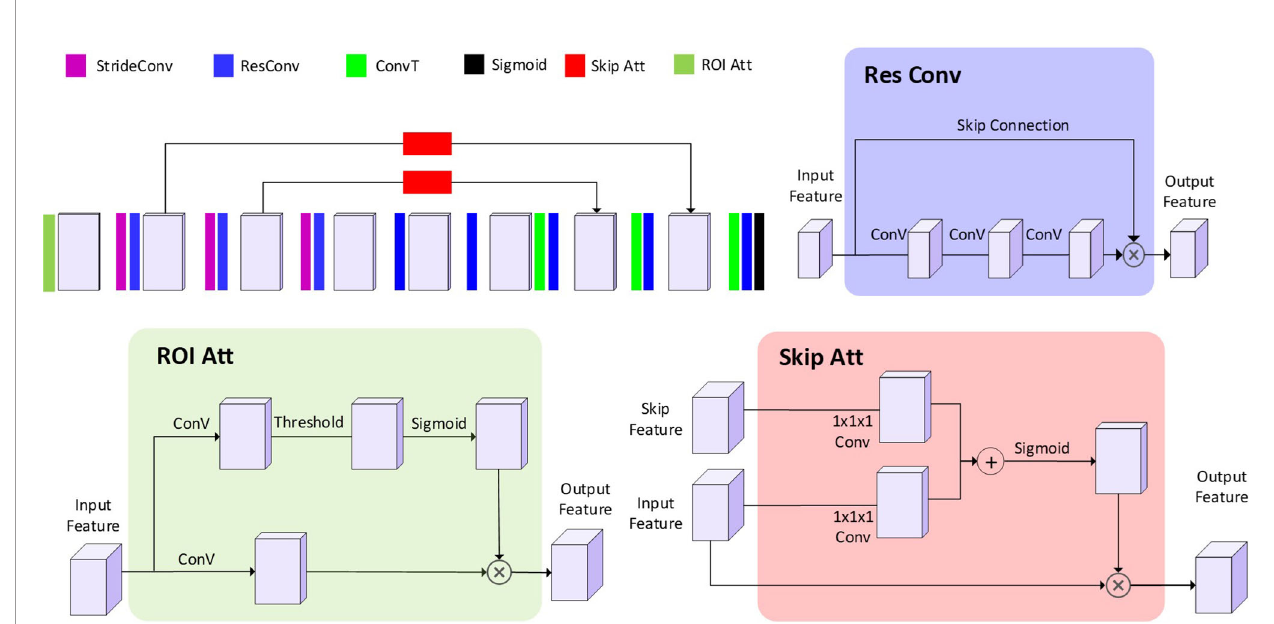
FIGURE 2 | The architecture of the proposed CNN model. The 3D blocks indicate the feature map. StrideConv was short for stride convolution. ResConv is short for residual convolution. ConvT is short for convolution transpose. Sigmoid is short for the sigmoid layer. Skip Att is short for the skip attention module. ROI Att is short for ROI